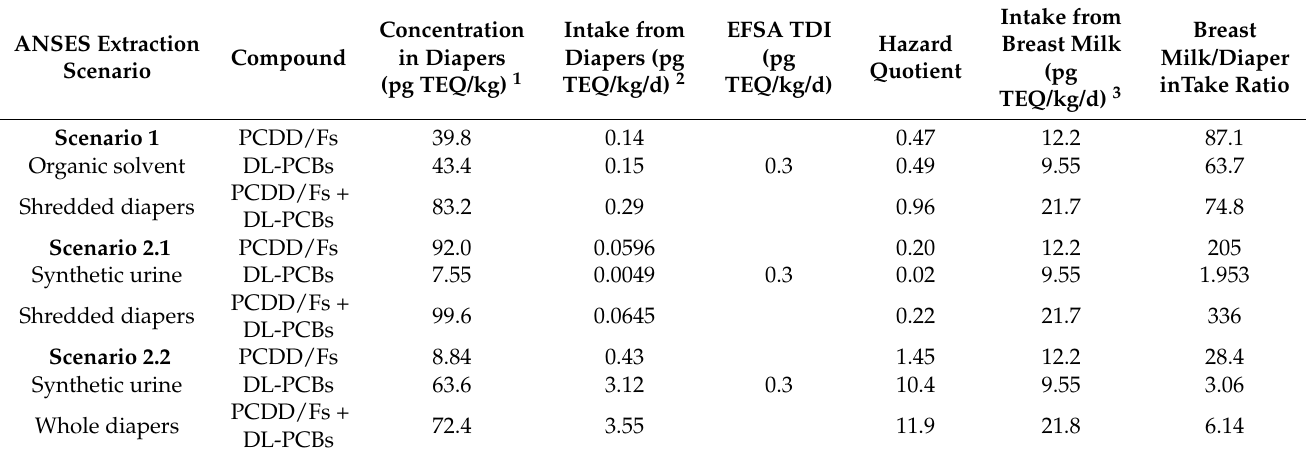
Table 2. Risk assessment of dioxins (PCDD/Fs) and DL-PCBs in diapers conducted by ANSES and comparison of the intake from diapers with that from breast